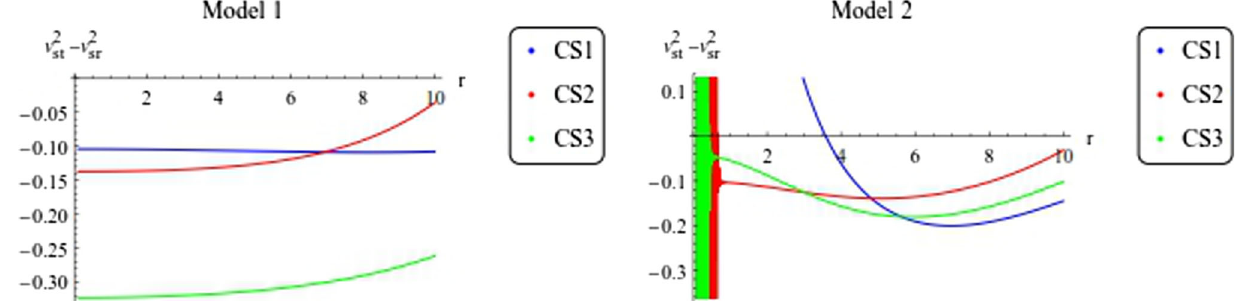
Fig. 12 Change in v 2 st − v 2 sr versus r (km) of CS1, CS2 and CS3